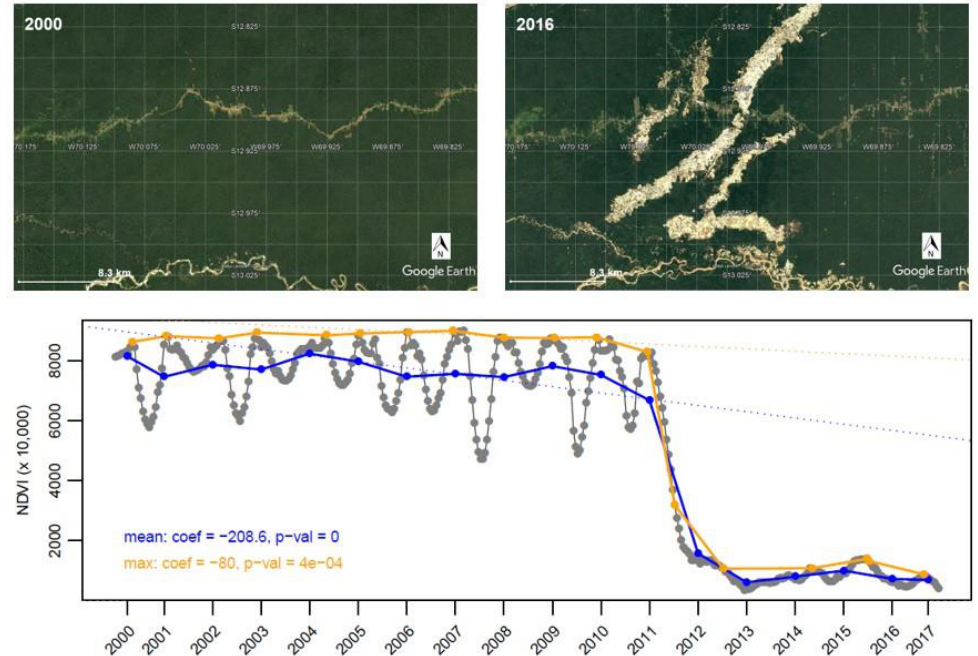
Figure 11. In the upper panels, high spatial resolution imagery from Google Earth Pro shows Amazon browning near Madre de Dios between 2000 and 2016. Removal of vegetation for mining results in a distinct stair-step NDVI trend. The accompanying graph shows the entire time-series of the NDVI data and fitted Thiel-Sen trends for NDVI-mean (blue) and NDVI-maximum (orange) for a pixel located at